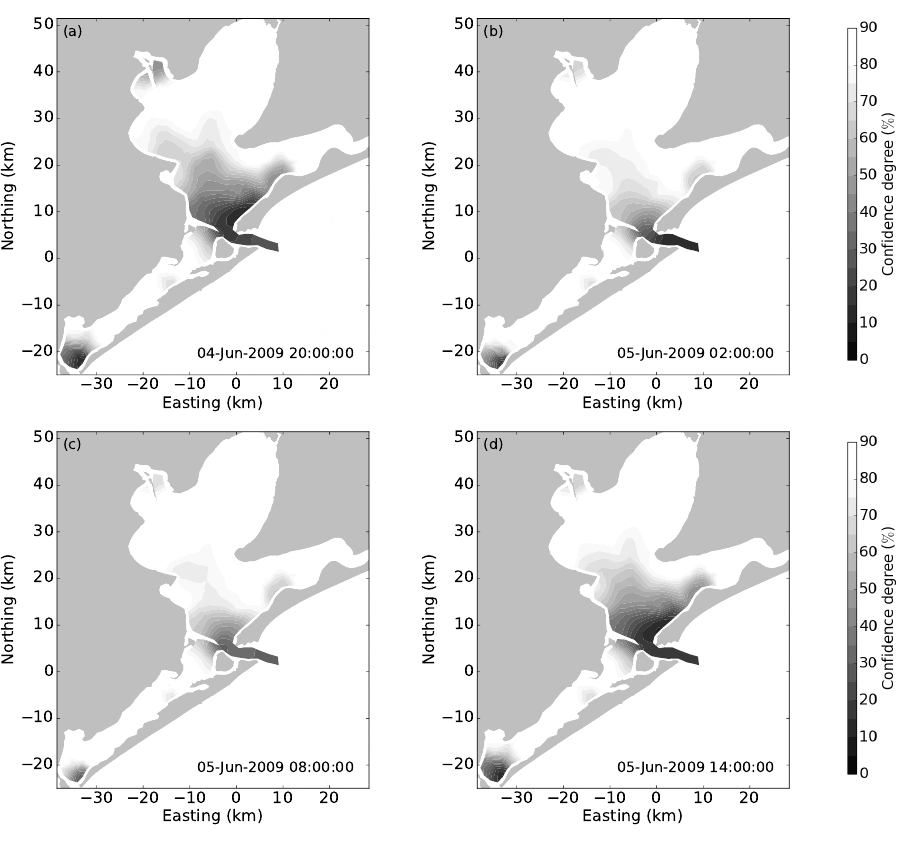
Figure 8. The predicted confidence degree ( C ) from the GBRT model at four flow conditions: ( a ) maximum flood tide, ( b ) moderate flood tide, ( c ) weak ebb tide (near slack water), and ( d ) maximum ebb